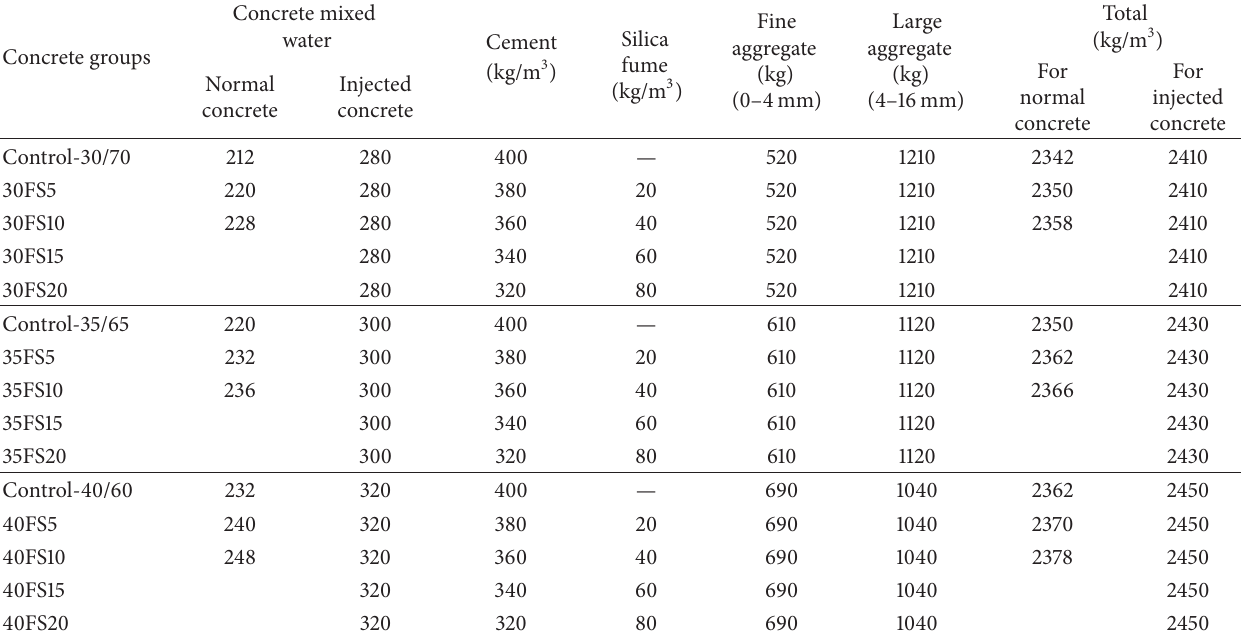
Table 1: Ratios of concrete